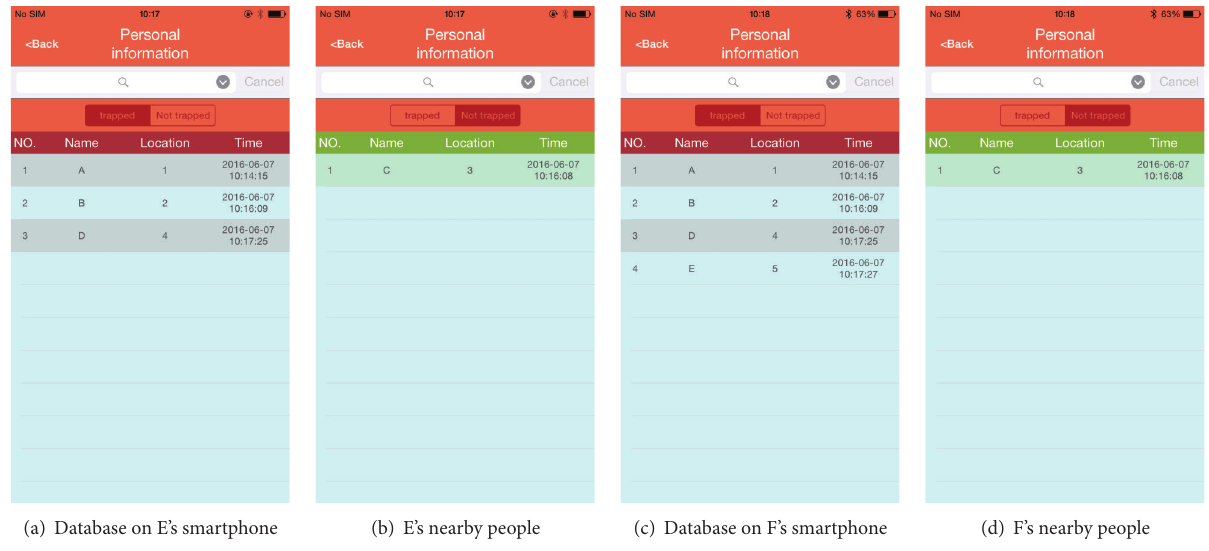
Figure 9: Results of moving node experiment.